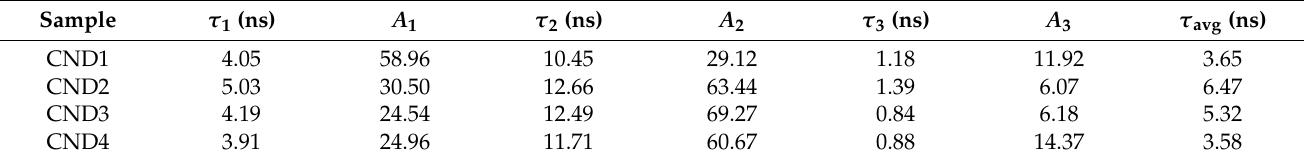
Figure 4. ( a ) TCSPC signals for CNDs recorded at detection wavelength of 450 nm with pump excitation wavelength of 374 nm. ( b ) NIR PL emission spectra of the CNDs. ( c ) Schematic illustration of emission pathways and related surface structures of the CNDs. Table 1. Fluorescence lifetimes of the